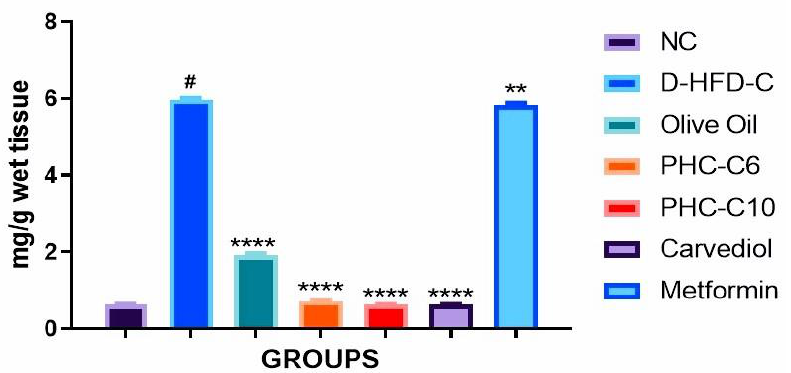
Figure 6. All values are expressed as mean ± SD ( n = 6) analyzed by one-way ANOVA followed by Tukey’s t -test. D-HFD-C was compared with NC ( # p < 0.0001), and the result was found to be highly significantly different. The different treatment groups were compared with D-HFD-C, and the re- sults were found to be different at the significance levels ** p < 0.01 and **** p < 0.0001. NC is normal control; D-HFD-C is diabetic high fat diet control group; PHC6 and PHC10 are polyherbal combi- nation treated groups.